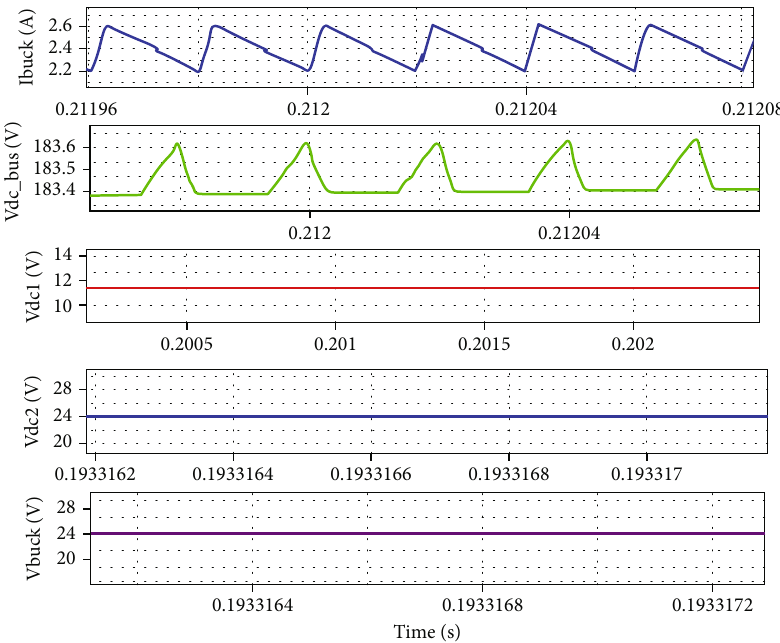
, V , V , and buck voltage V dc bus dc1 dc2